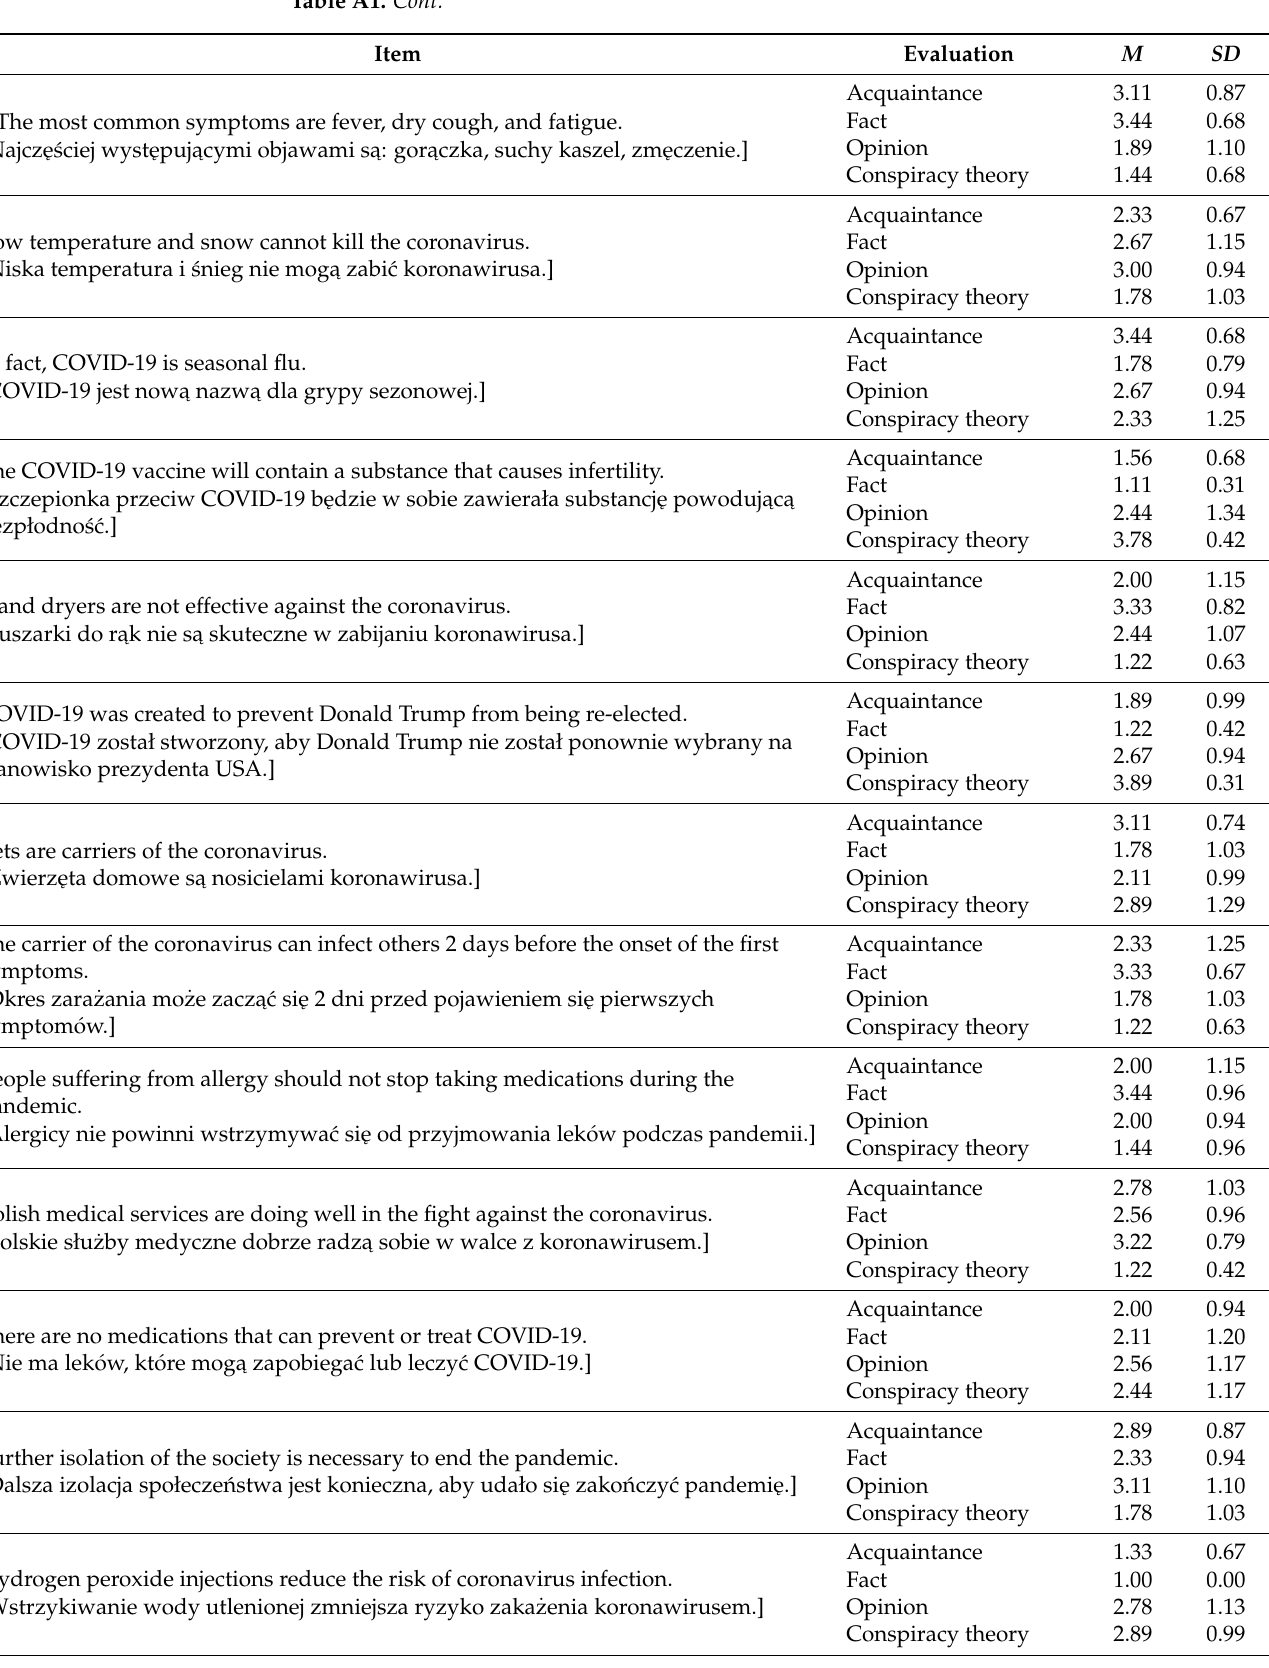
Table A1. Cont. Item